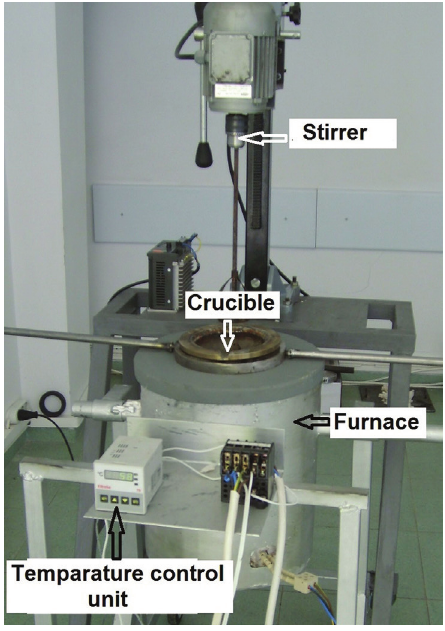
Fig. 1: Experiment setup for the melt